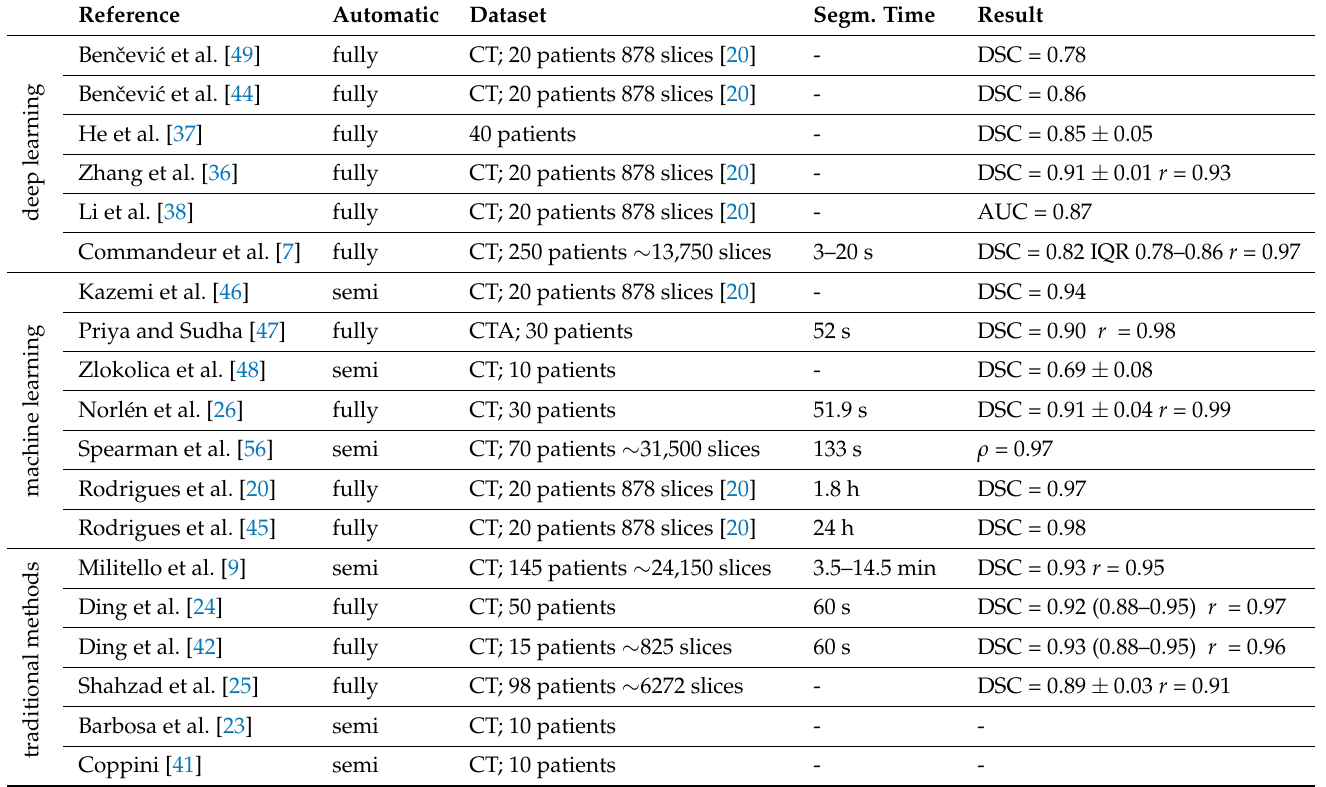
Table 2. Epicardial adipose tissue segmentation methods. DSC is the reported Dice coefficient, r is the Pearson correlation coefficient, AUC is the area under curve measurement and ρ is the Spearman correlation coefficient. Segmentation time is the reported time to segment a single CT